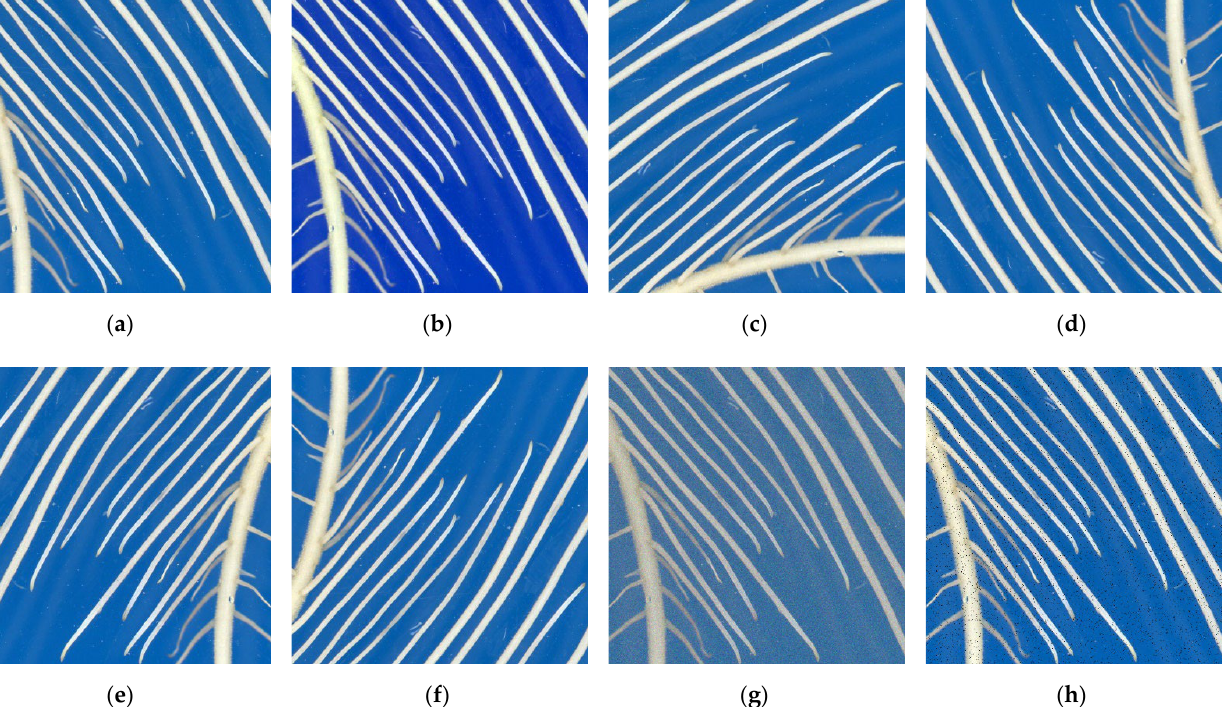
Figure 3. Root system picture after data augmentation. ( a ) Original image; ( b ) Adjust HSV; ( c ) Ro- tate 90° counterclockwise; ( d ) Rotate 180° counterclockwise; ( e ) Horizontal Flip; ( f ) Vertical Flip; ( g ) Gaussian noise; ( h ) Pepper noise.